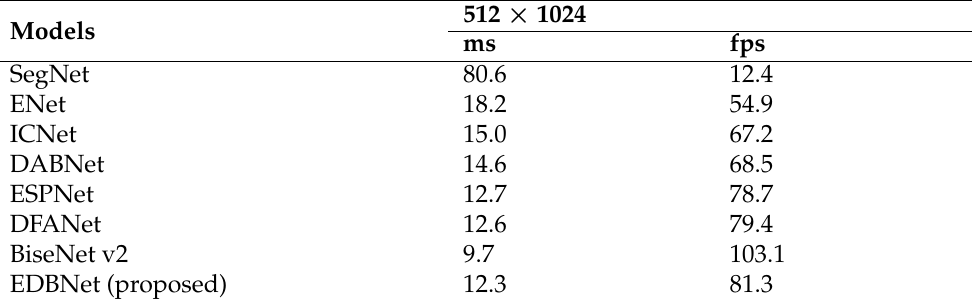
Table 3. Testing Results of Inference